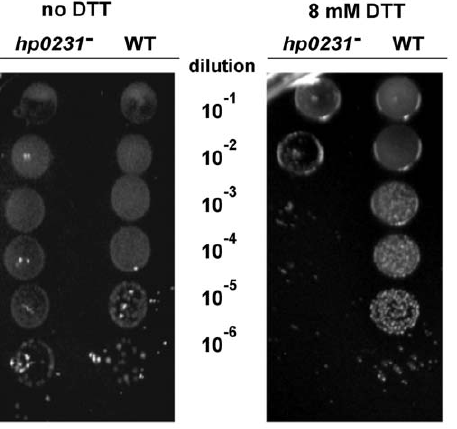
Figure 2. The H.pylori N6 hp0231 :: cat mutant is DTT sensitive. Exponentially growing H. pylori wt and hp0231 :: cat cultures were ten- fold serial diluted and spotted on BA plates without (panel A) or with (panel B) 8 mM DTT, and incubated at 37 u C. The mutant shows reduced growth after 3 days of incubation on plates containing DTT.